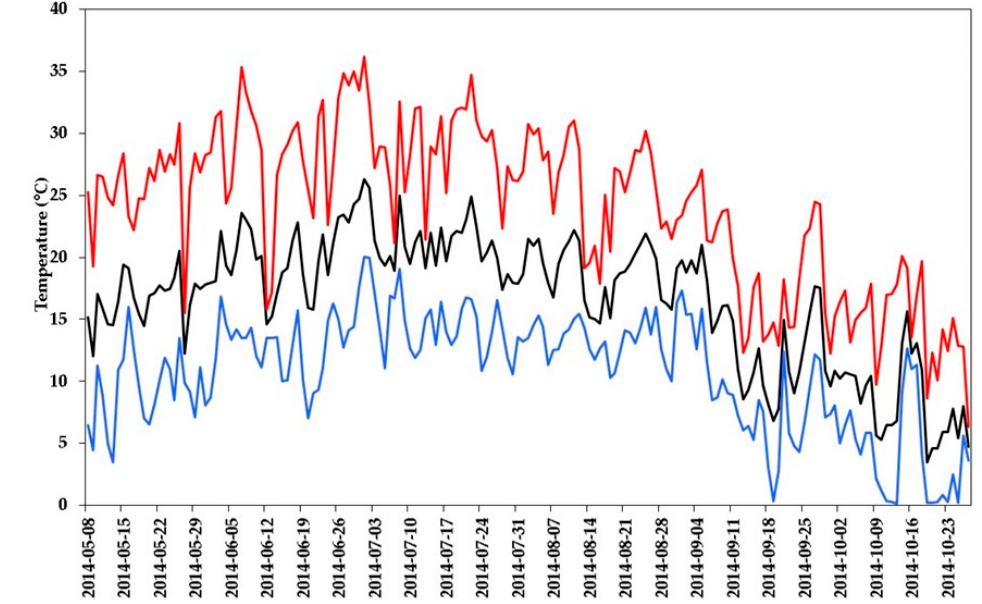
Figure 3. Variation of maximum (red), mean (black) and minimum (blue) daily temperatures at the substrate-cover material interface (Silica or material Calcite) during the first growing season of white spruce seedlings (1 + 0) in a tunnel.